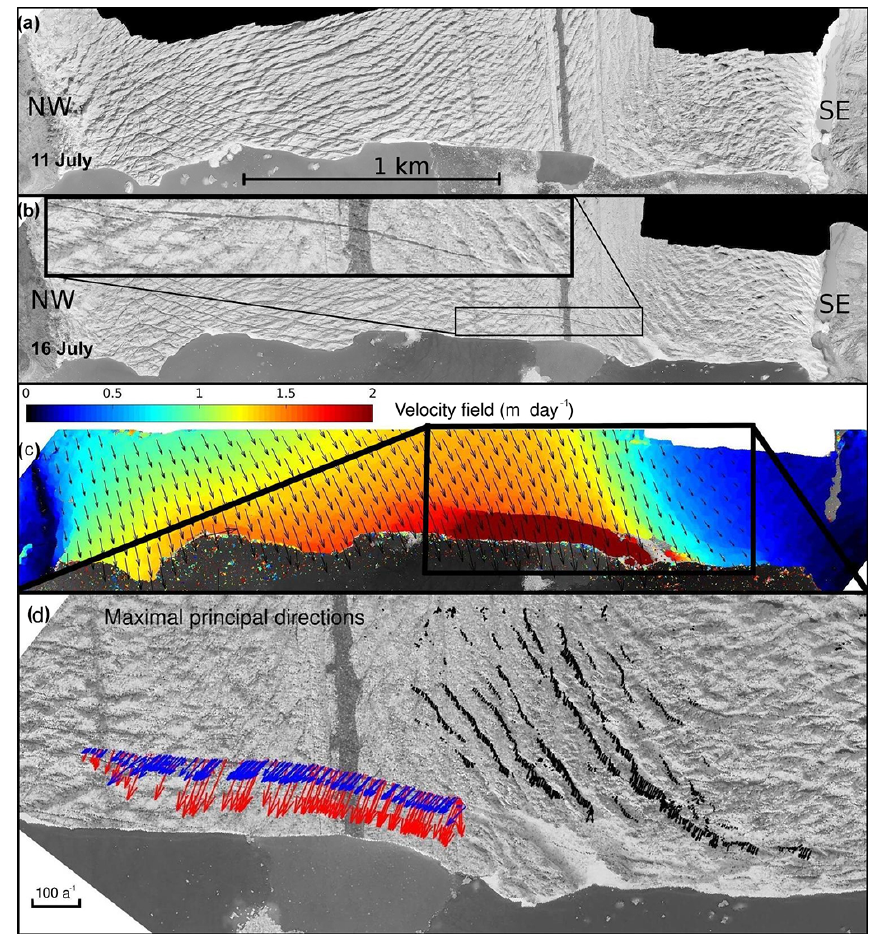
Figure 2. Calving front of the Bowdoin Glacier: orthoimages were obtained by UAV on (a) 11 and (b) 16 July, with the resulting velocity field inferred using feature tracking (c) and the maximum principal directions of the strain rate (d) , respectively. For the sake of visualization, only the maximum directions with a magnitude above 5yr − 1 are drawn on (d) . The vector lengths scale with the magnitude of the maximal principal strain rate. A scale corresponding to 100yr − 1 is shown as reference. Blue and red arrows stand for principal directions on the upstream and downstream edge of the crack,